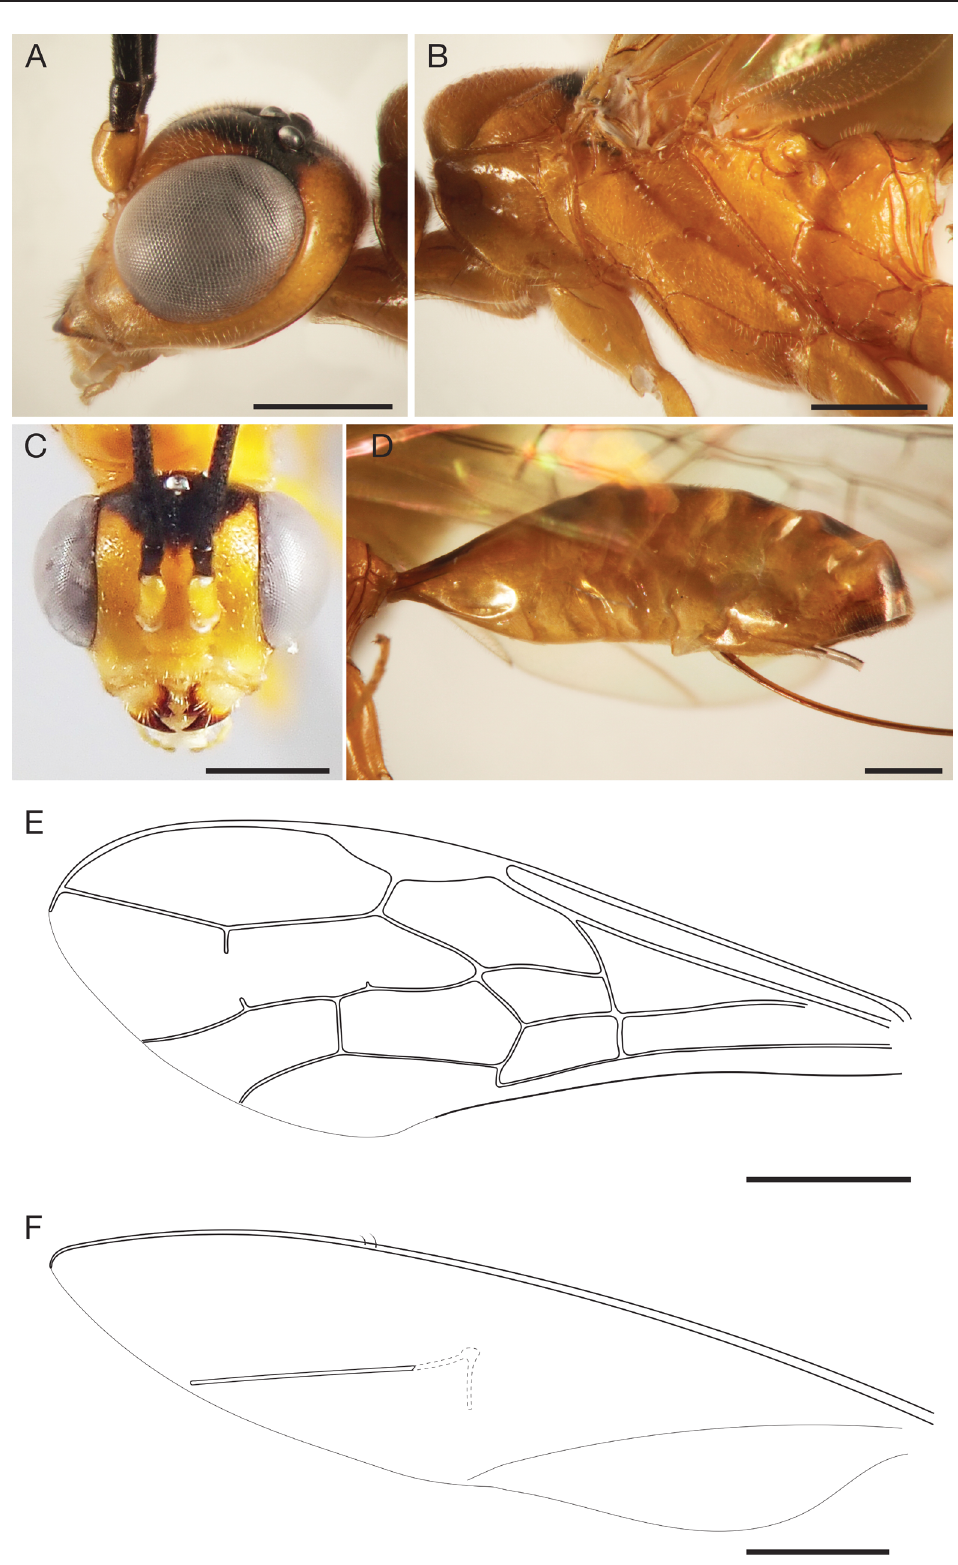
Fig. 4. Pristaulacus elveni sp. nov., holotype, ♀ (MNHN). A . Head in lateral view. B . Mesosoma in lateral view. C . Head in full-face view. D . Metasoma in lateral view. E . Line drawing of fore wing venation. F . Line drawing of hind wing venation. Scale bars: A–D, F = 0.5 mm ; E =